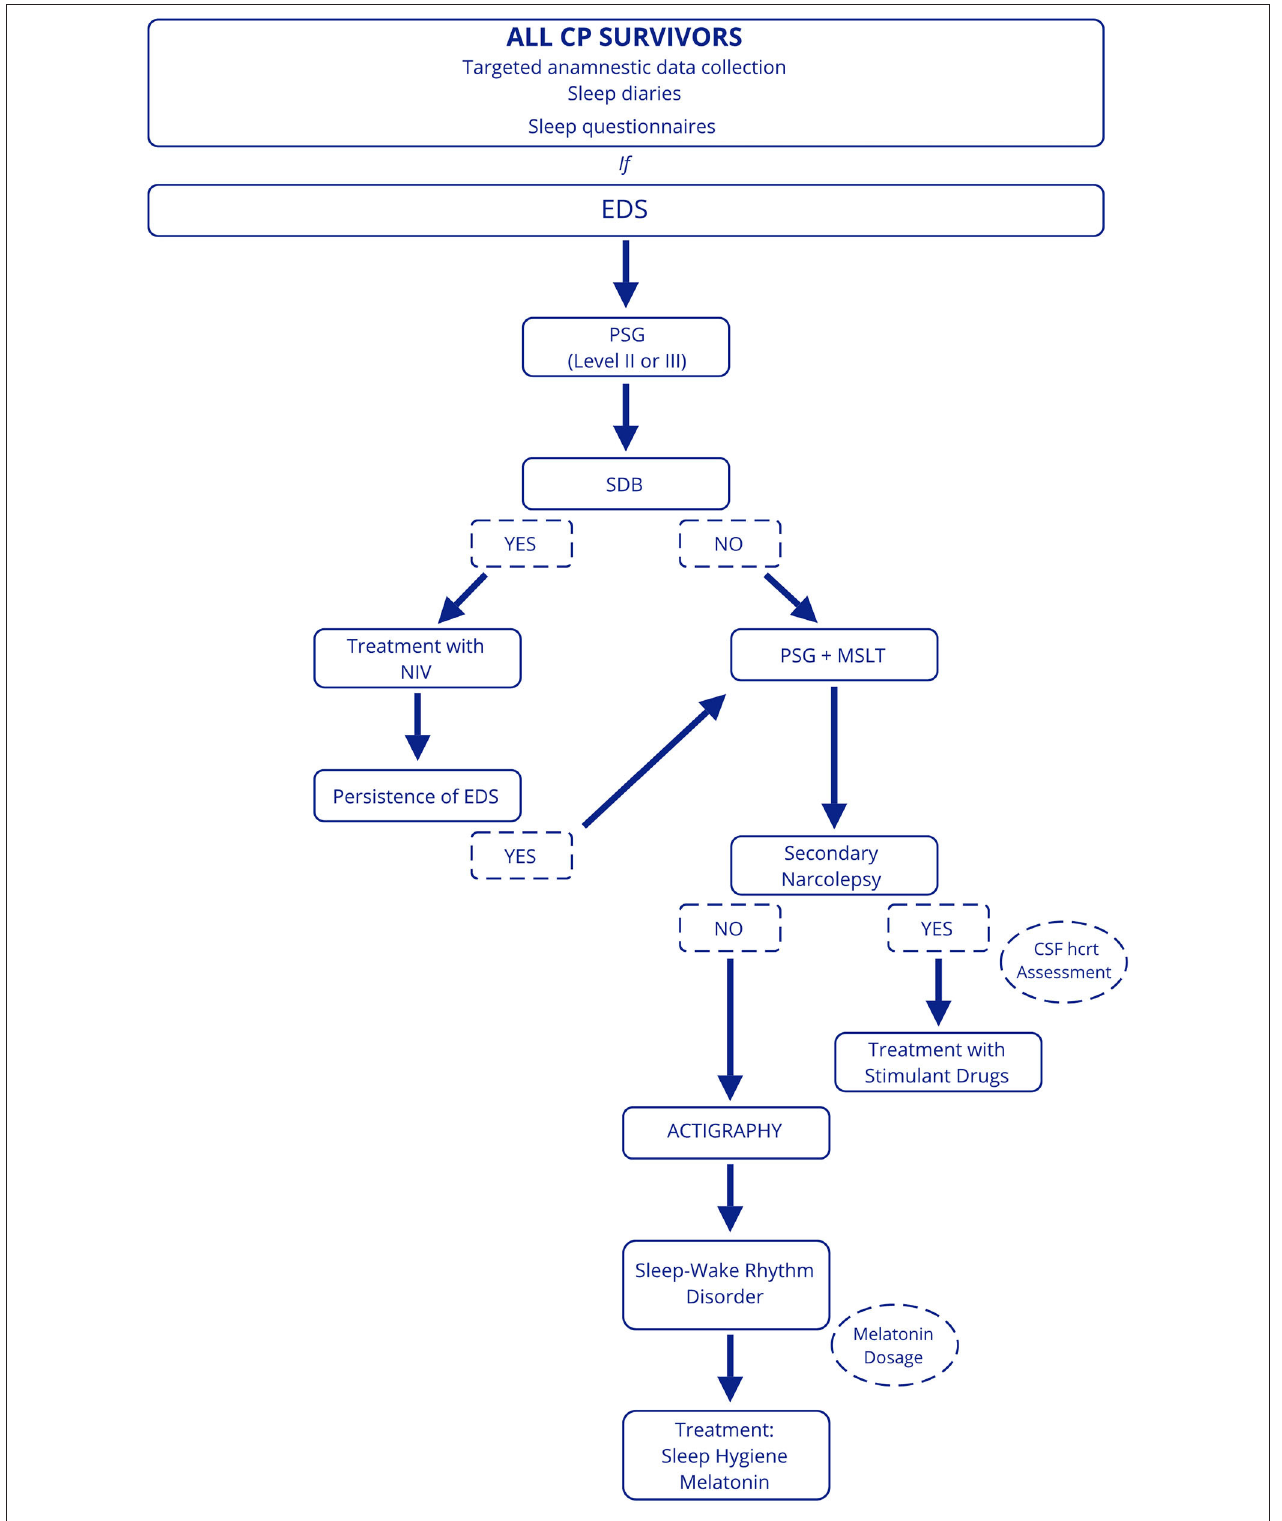
FIGURE 3 | Proposed diagnostic work-up in patients with CP. EDS, excessive daytime sleepiness; PSG, polysomnography; SDB, sleep-disordered breathing; NIV, non-invasive ventilation; MSLT, Multiple Sleep Latency Test; hcrt, hypocretin.